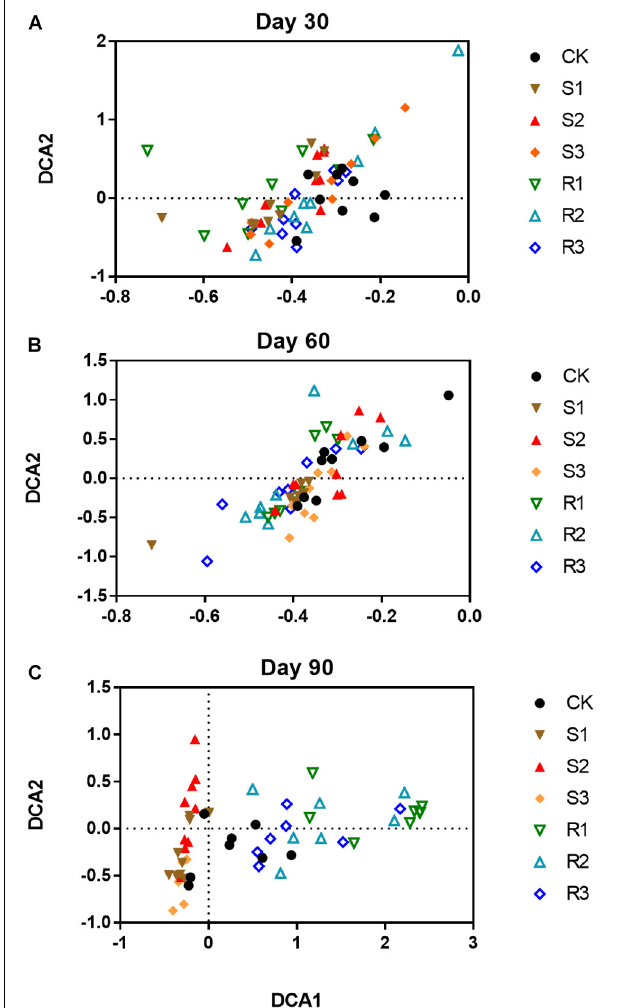
FIGURE 2 | The ordination plots of all samples for the community structure analyzed by detrended correspondence analysis (DCA) on day 30 (A) , 60 (B) , and 90 (C) . CK: control group; Treatment with three root functional microflora (R1, R2, and R3) and with three soil functional microflora (S1, S2, and